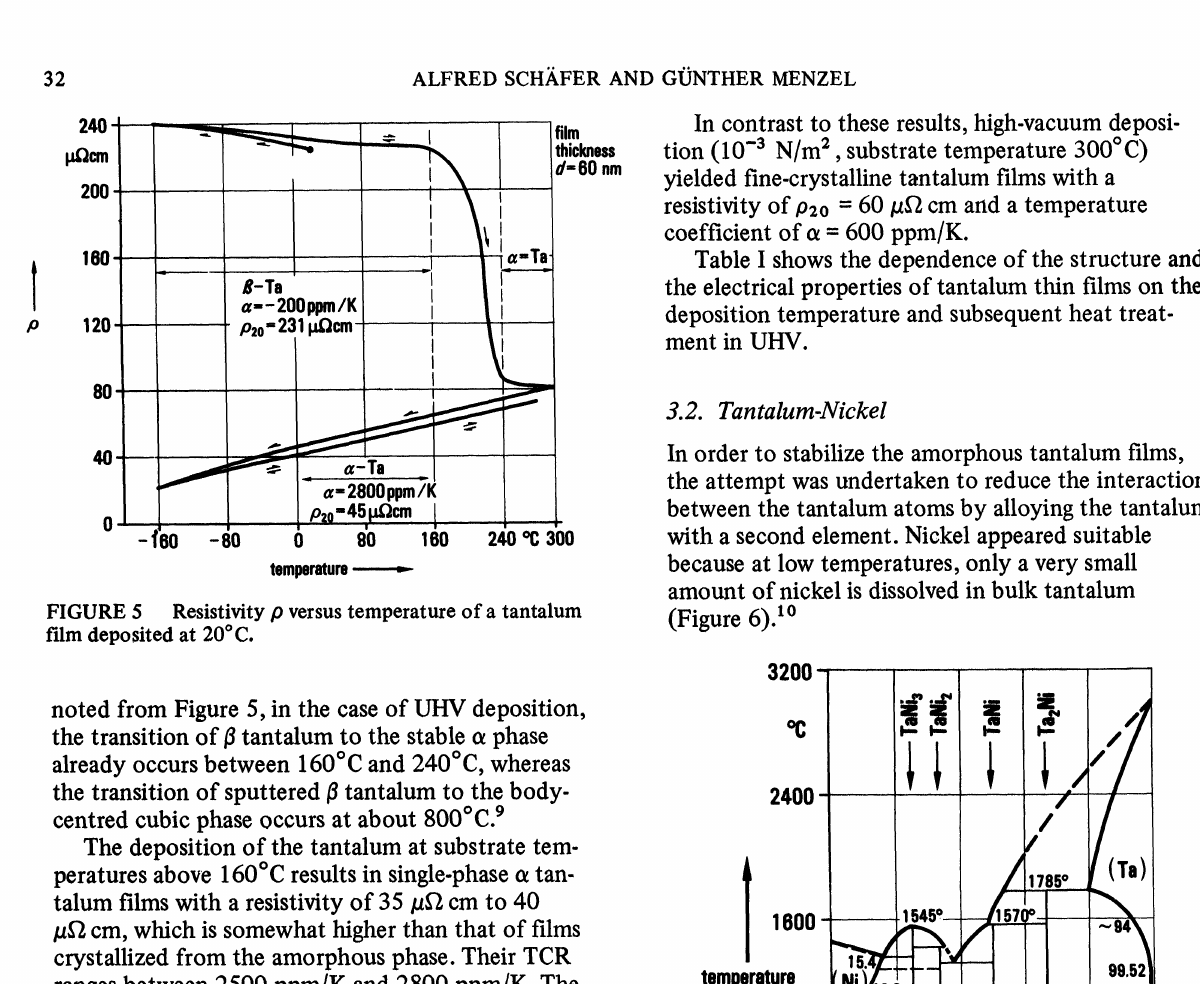
TABLE Dependence of structure and electrical properties of tantalum